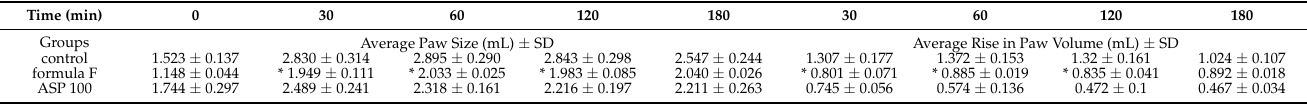
Table 4. Average paw size (mL) at 0, 30 min, 1 h, 2 h and 3 h after causing